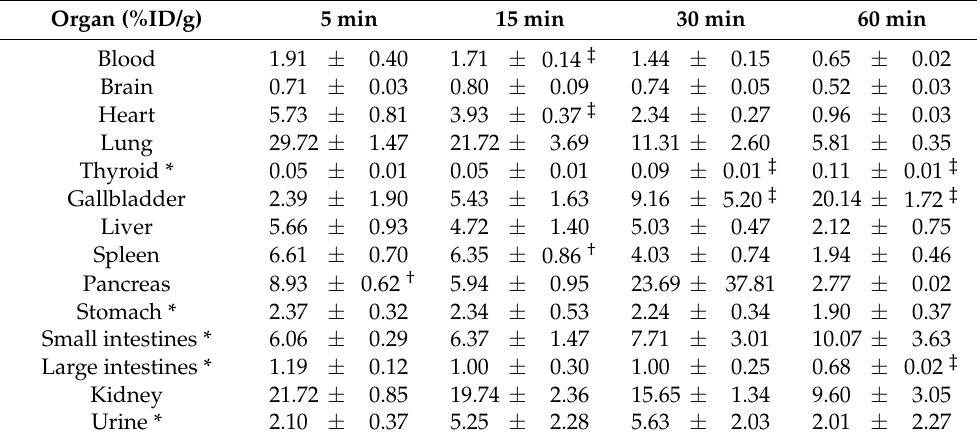
Table 2. Biological distribution of 125 I-ODV and metabolite of 125 I-ODV (CYP3A4 inhibition). Organ